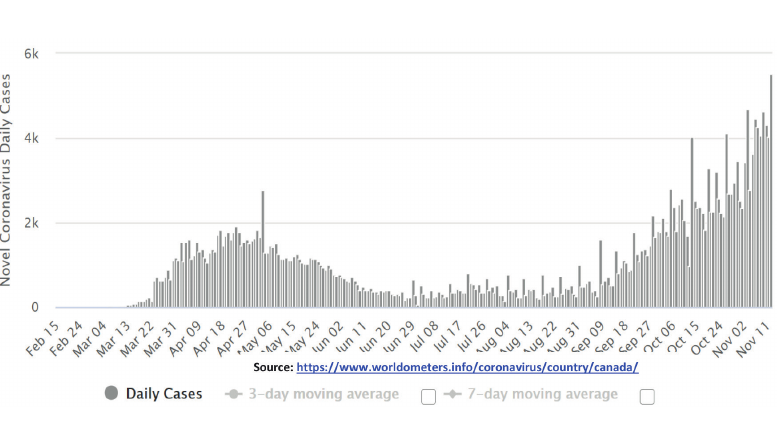
Figure 1: Daily new cases of CoViD-19 in